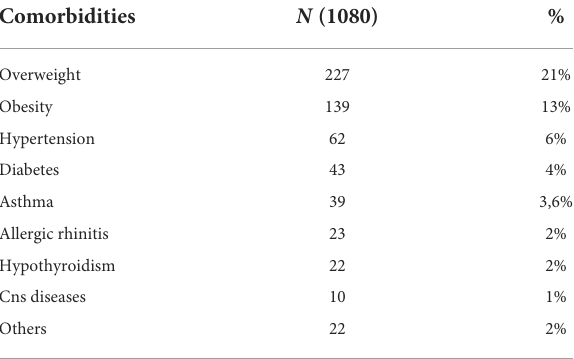
TABLE 2 Frequency of comorbidities in the patients included for the